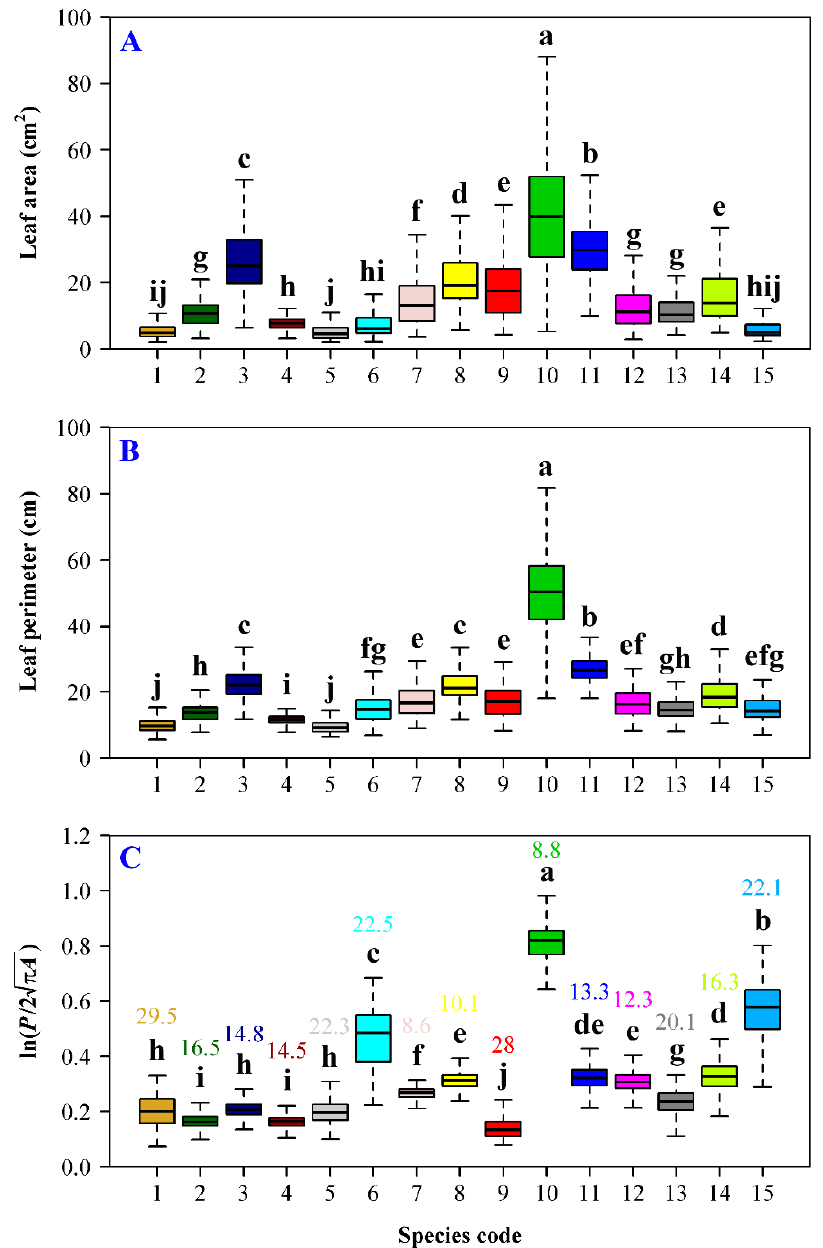
Figure 4. Boxplots of leaf surface area ( A ), leaf perimeter ( B ), and the natural logarithm of the ratio of leaf perimeter to a proportionality of the square root of leaf surface area ( C ). The numbers on the whiskers of the boxes in panel C represent the coefficients of variation in ln(DI), where DI is equal to 𝑃 2√π𝐴⁄ , P is the leaf perimeter, and A is the area. The numbers on the top of the whiskers refer to the coefficients of variation of the dissection indices. Different colors represent different species of vines.